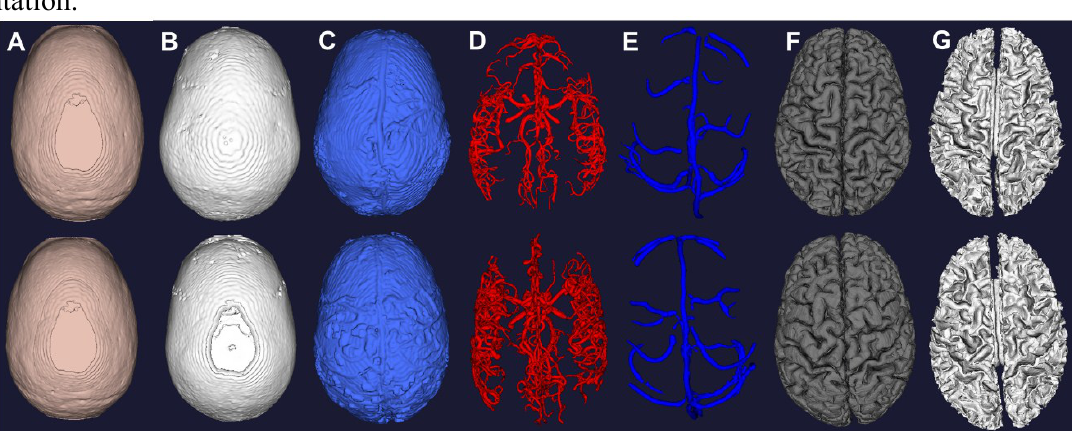
Figure 4. Computational meshes constructed from image segmentation of the two subjects. ( A ) Scalp from morphological operations of T1; ( B ) Skull from morphological operations of T1; ( C ) CSF from auto thresholding of T2; ( D ) Arteries from vessel filtering and segmentation of MRA; ( E ) Veins from vessel filtering and segmentation of MRV; ( F ) Grey matter from surface segmentation; ( G ) White matter from surface